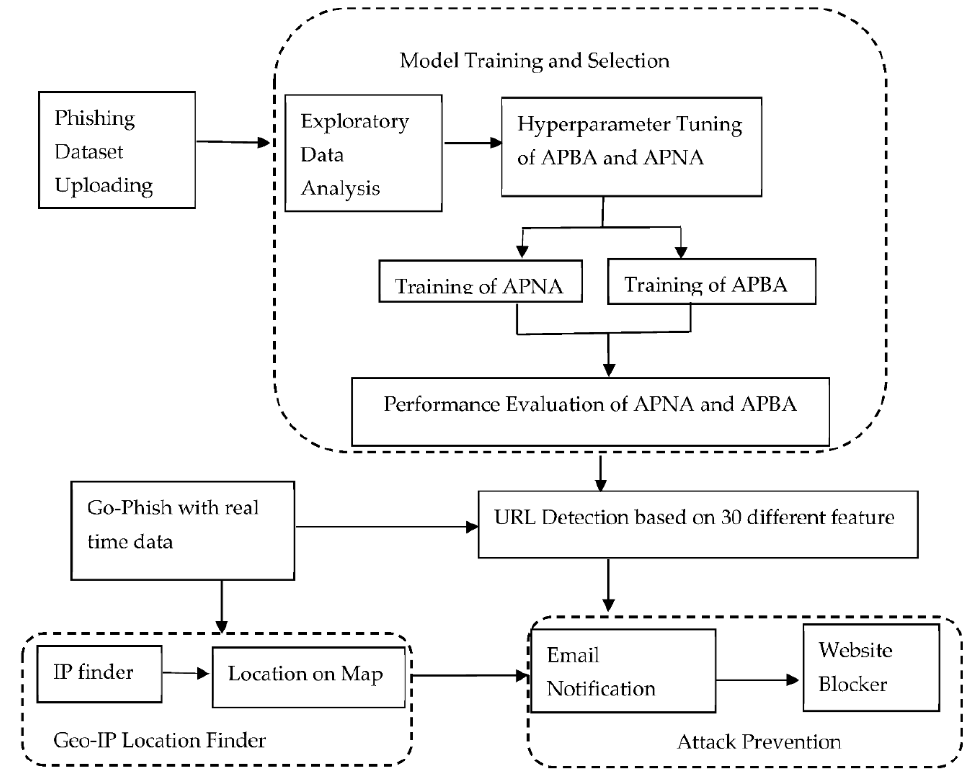
Figure 1. Proposed dynamic phishing safeguard system .